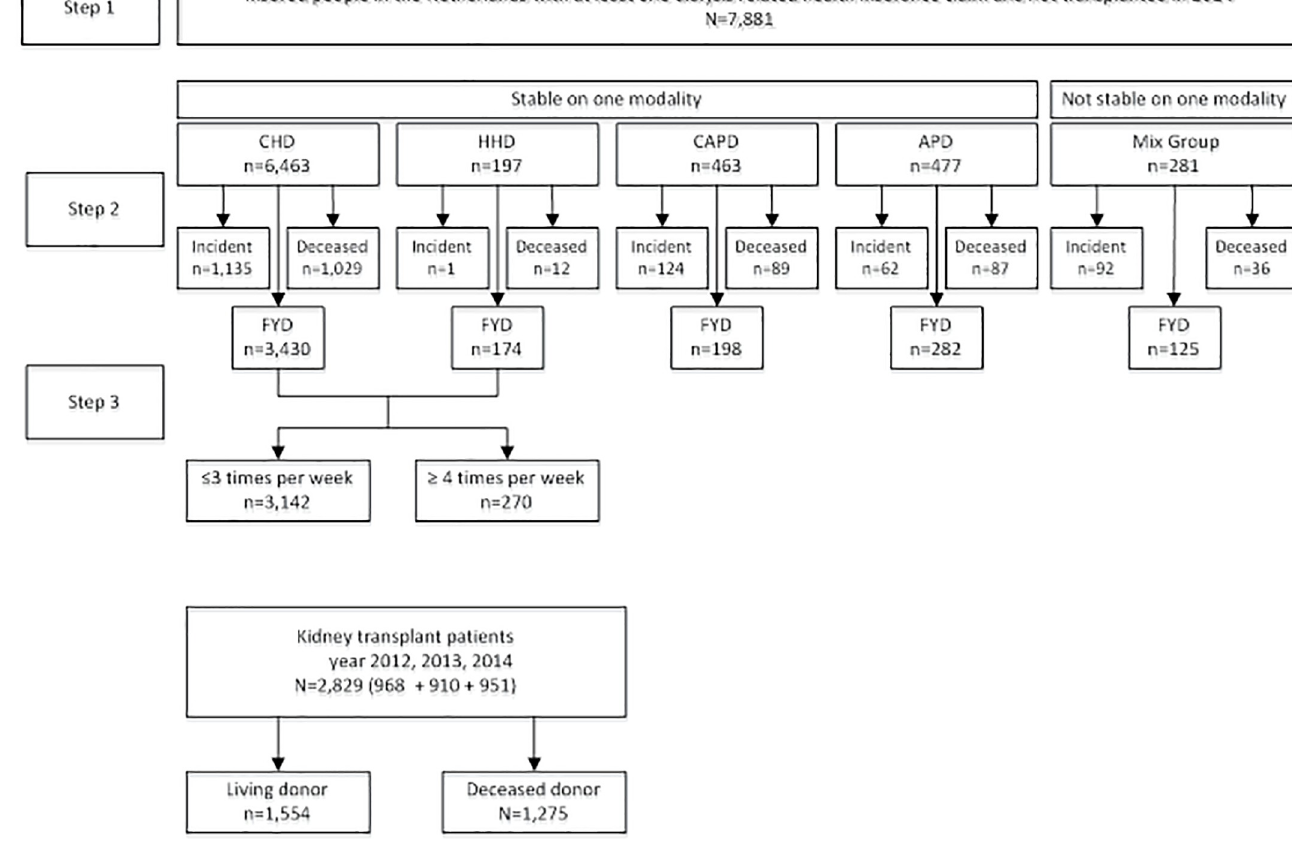
PLOS ONE | https://doi.org/10.1371/journal.pone.0220800 August 15,